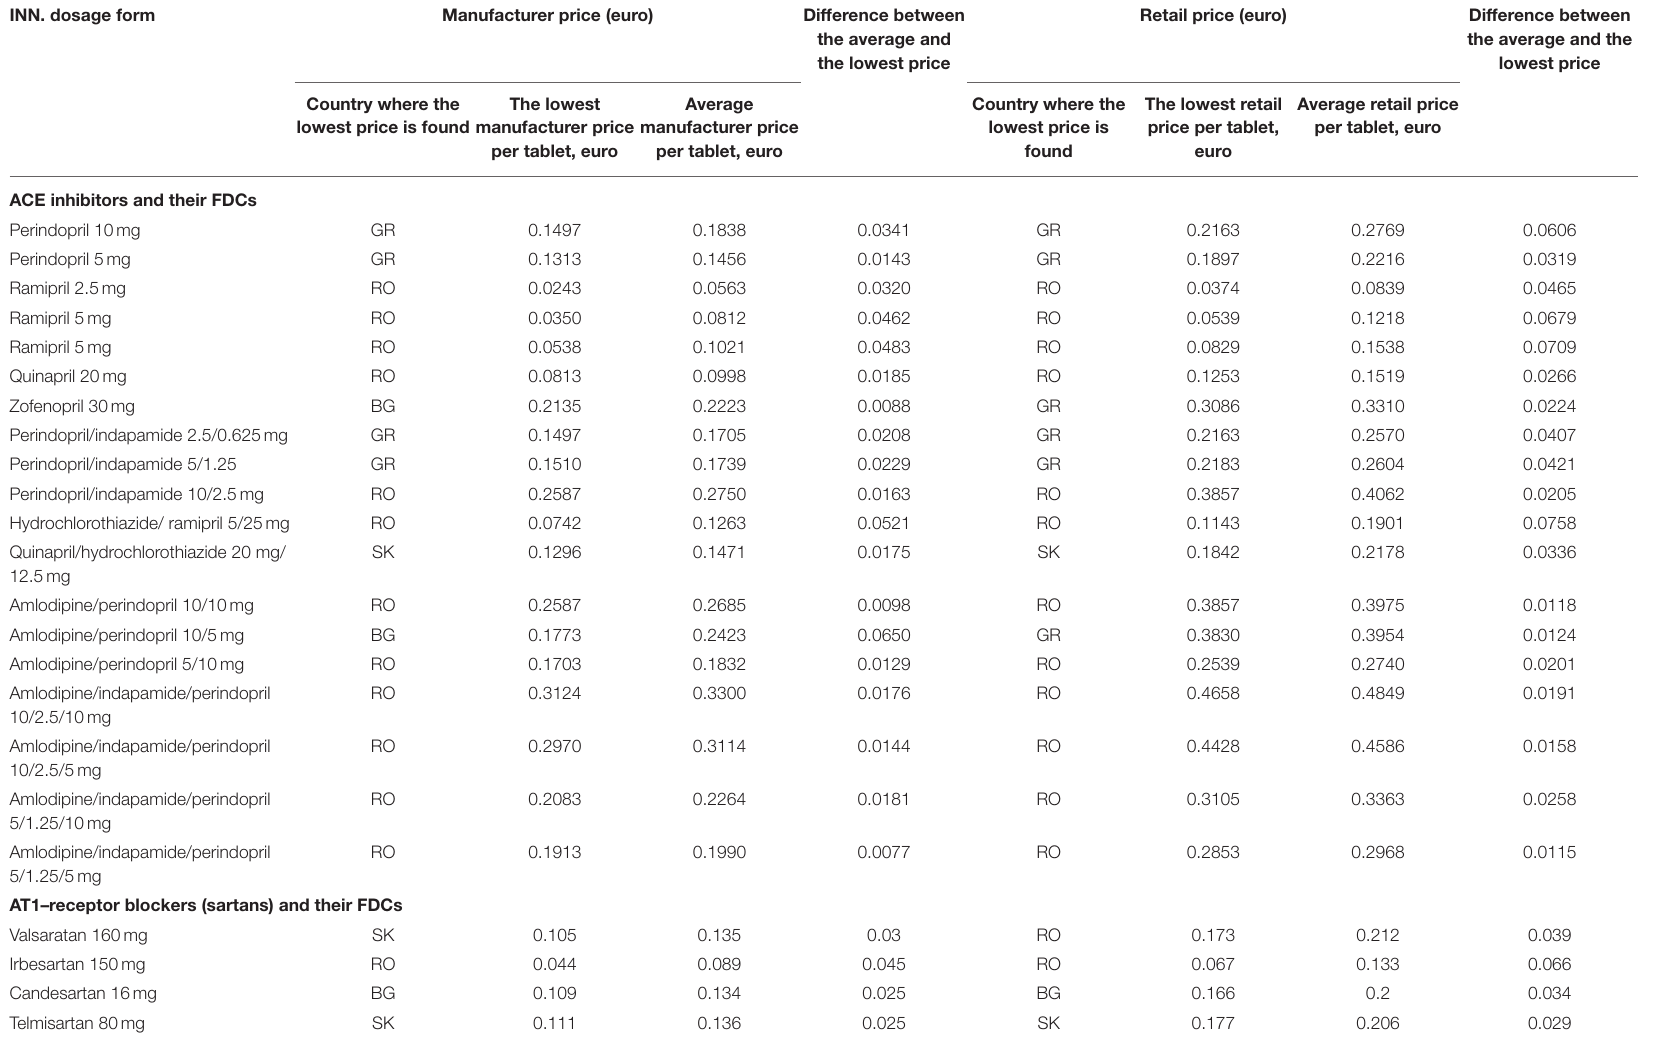
TABLE 3 | The lowest and average price per tablet on the manufacturer and retail